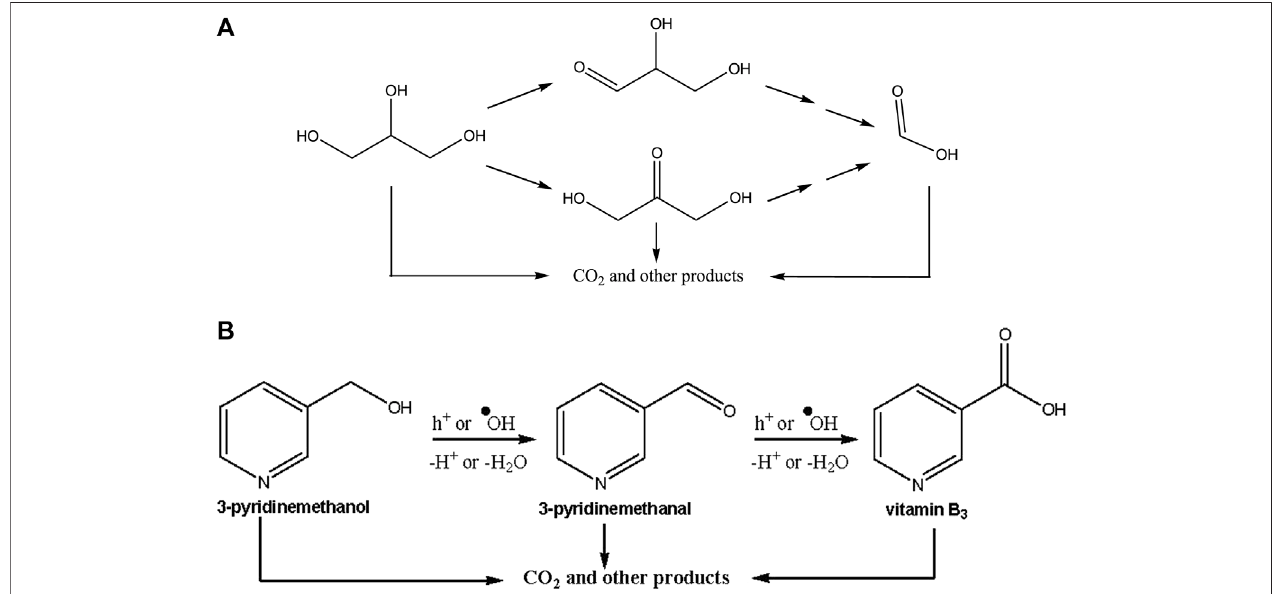
TABLE 4 | The results of photocatalytic glycerol (2 mM) oxidation under UVA light with TiO 2 photocatalysts. Photocatalyst X 8h (%)